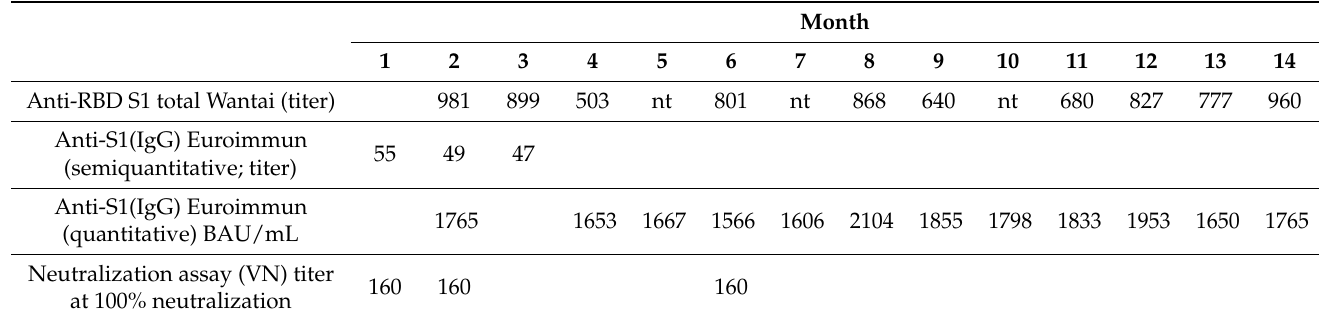
Table 2. Results of stability tests of GAMMA anti-SARS-CoV-2 globulin (hIHGG anti-SARS-CoV- 2, lot 0120) detecting specific anti-S1 RBD antibodies (total IgG, IgA and IgM), anti-S1 IgG and neutralizing antibodies (neutralization test). Results presented as titers (except VN) were estimated by the four-parameter non-linear regression method. nt: not